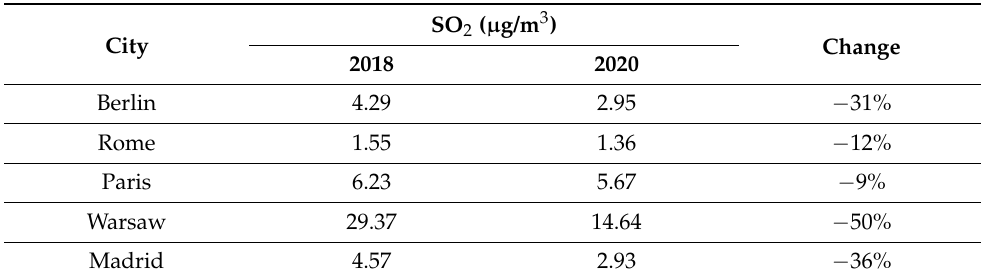
Table 6. The average change in SO 2 concentration on 20 March to 15 April 2018 and 2020 in selected European